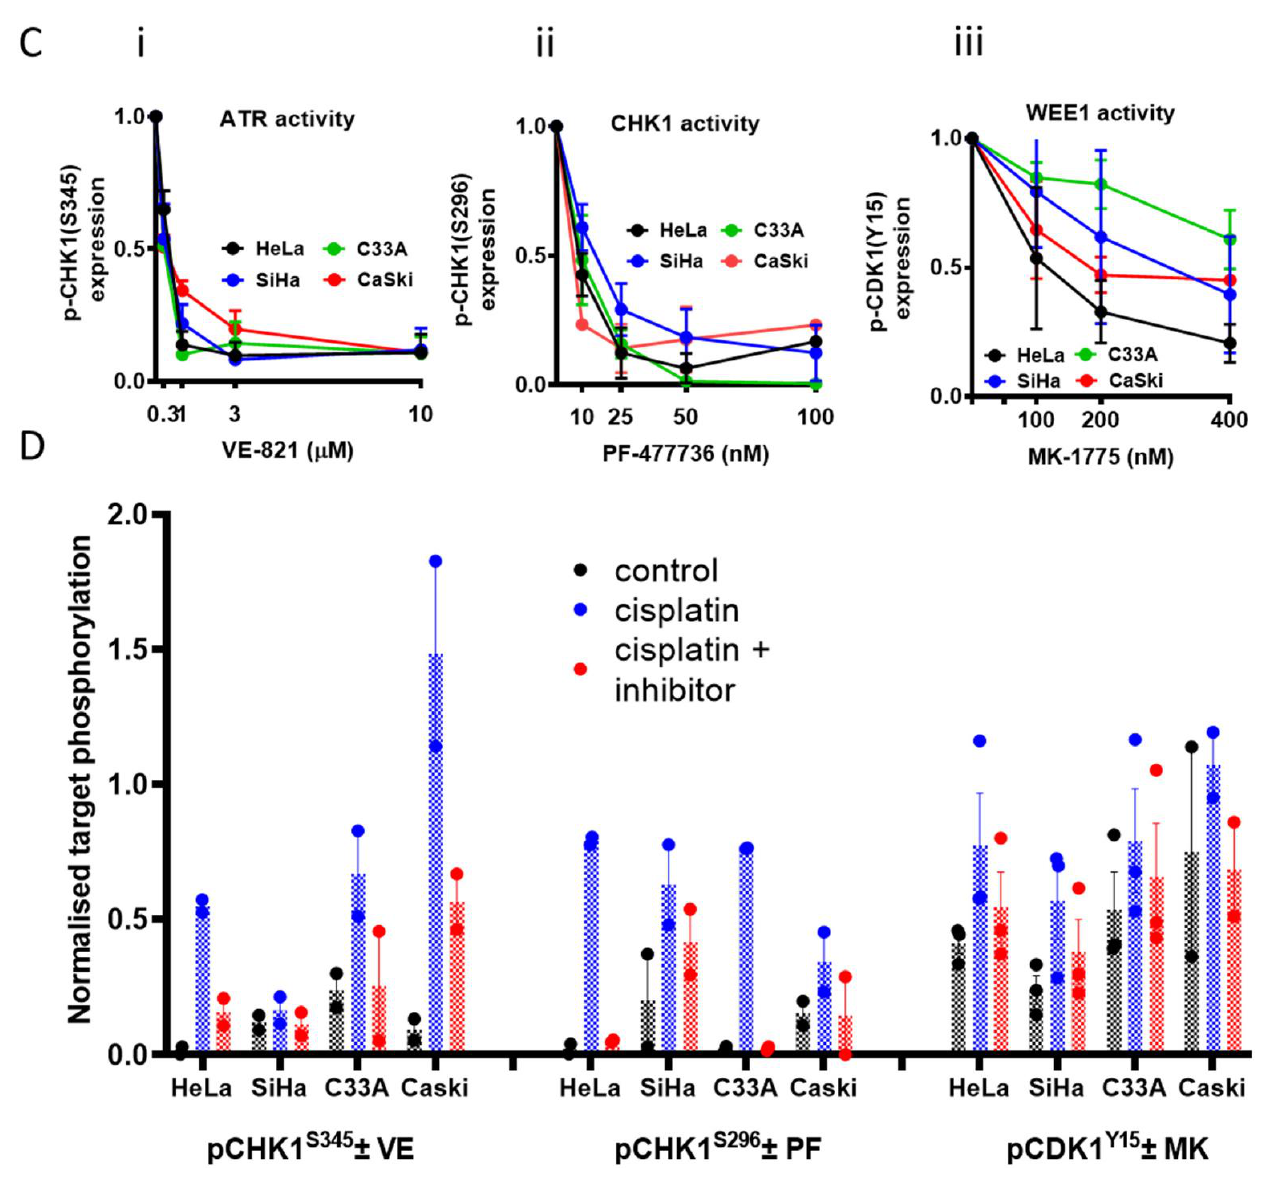
Figure 2. DDR activation by ionising radiation (IR) and cisplatin and inhibition by drugs targeting these pathways: PARP activity was measured by immunofluorescence detection of the product, PAR, in exponentially growing HeLa cells. Cells were fixed immediately after exposure to 16 Gy IR or 6 h incubation with 500 uM cisplatin at 37 °C. ( A ) Representative images are shown alongside a bar chart of the percentage of PAR positive nuclei, data are mean ± SD from four independent experiments. The difference of PAR positive cells between untreated, IR and cisplatin ± rucaparib treated groups were compared using unpaired t -test. ** and **** are p < 0.01 and 0.0001 respectively. ( B ) Co-localisation of PAR positive HeLa cells with replication stress marker RPA and cell proliferation marker Cyclin E indicates PARP activation in replicating cells only in response to cisplatin. Images at 40× magnification. ( C ) pCHK1S345, pCHK1S296, and pCDK1Y15 levels in cells treated with increasing concentrations of ( i ) VE-821, ( ii ) PF-477736 and ( iii ) MK-1775, respectively (Supplementary Figure S4). Data represents mean ± SEM (N = 3). ( D ) Analysis of ATR, CHK1 and WEE1 activity from densitometric analysis of pCHK1S345, pCHK1S296, and pCDK1Y15, respectively, in Western blots of exponentially growing cell exposed to 0.5% DMSO alone, 3 μM cisplatin and 3 μM cisplatin + 1 μM VE -821 (VE), 50 nM PF-477736 (PF) or 100 nM MK-1775 (MK) for 24 h prior to harvest cells and lysate preparation (Supplementary Figure S4). Data represents mean of two independent experiments.